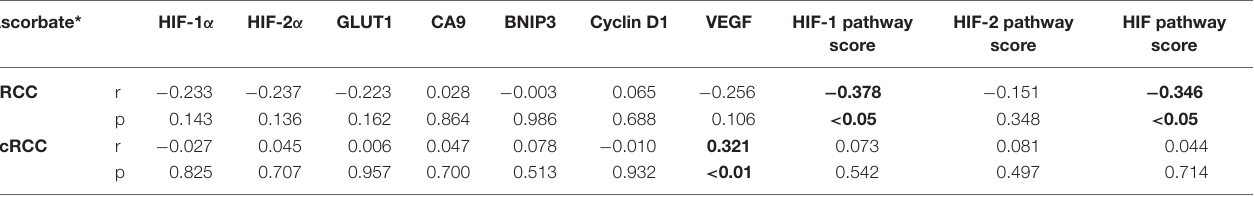
TABLE 3 | Spearman correlations between tumor ascorbate content and HIF pathway proteins and HIF pathway scores for pRCC ( n = 41) and ccRCC patients ( n = 73). Ascorbate* HIF-1 α HIF-2 α GLUT1 CA9 BNIP3 Cyclin D1 VEGF HIF-1 pathway